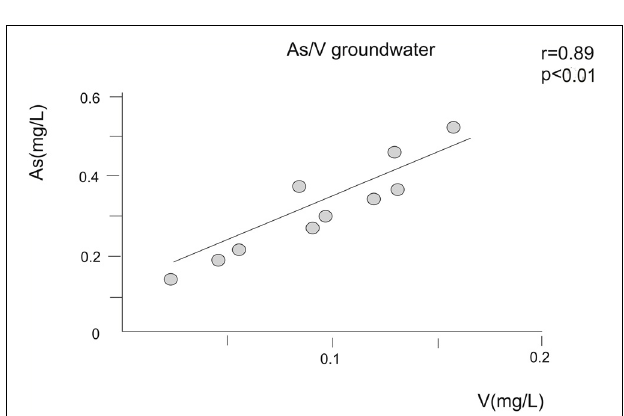
FIGURE 3 | Correlations between As and F − in groundwater.